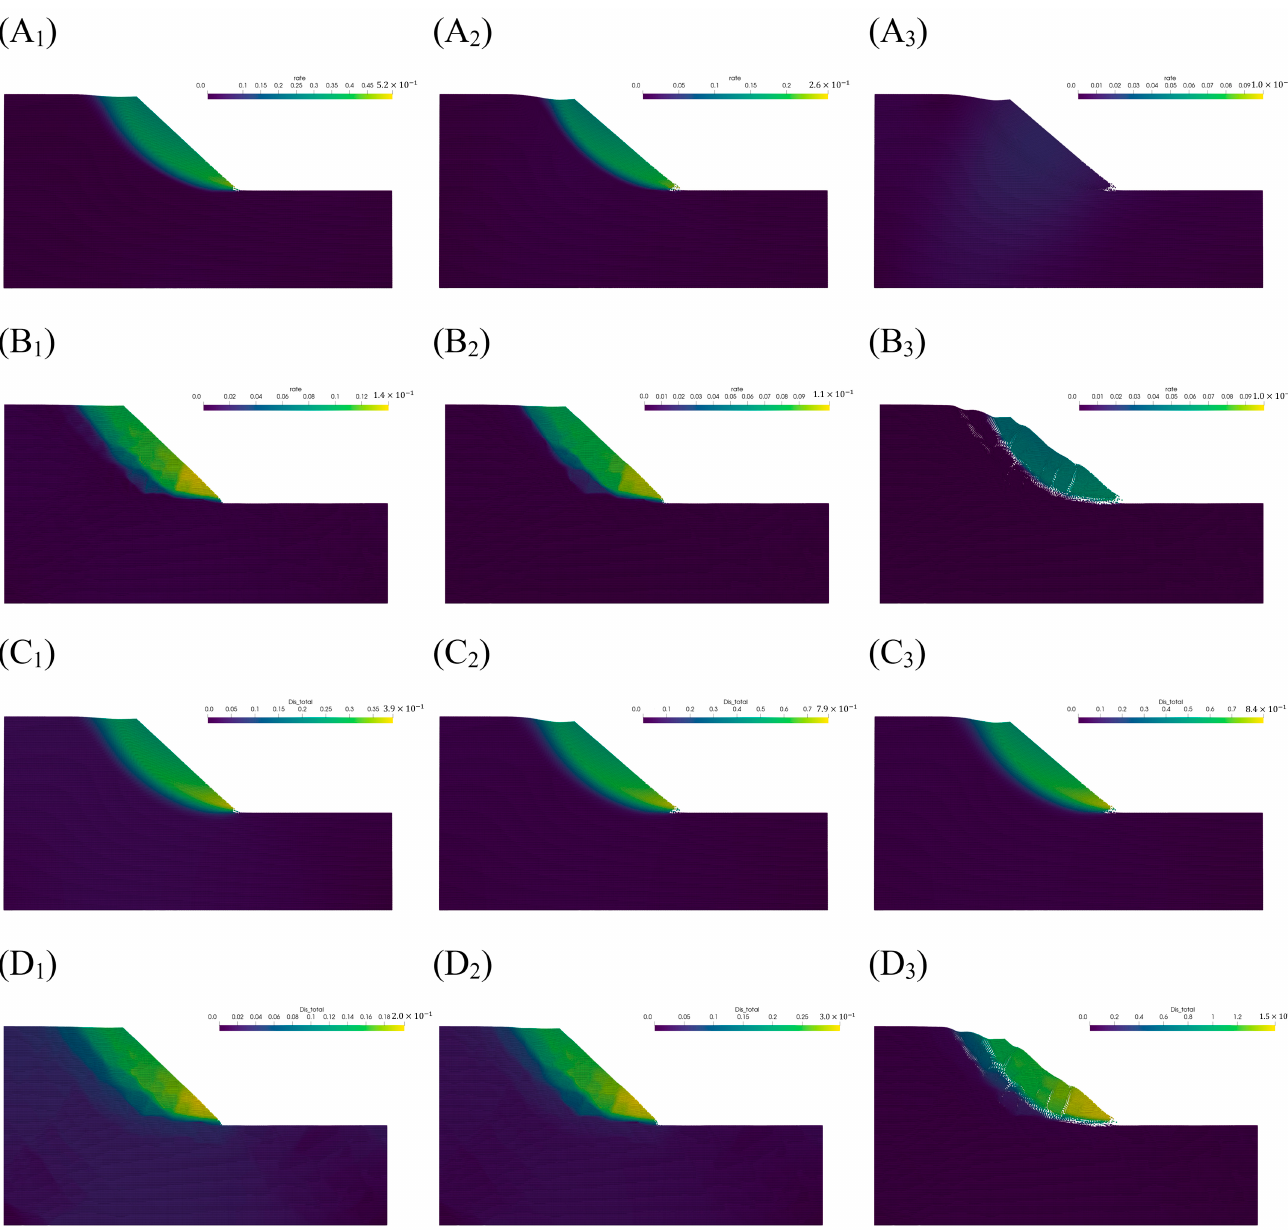
Figure 7. Rate and displacement cloud variation of pure soil slopes and SRM slopes for reduction factors equal to 1.5 and 1.9, respectively. ( A 1 – A 3 ) Rate distribution of pure soil slope at t = 3, 4, and 22 s. ( B 1 – B 3 ) Rate distribution of SRM slope at t = 3, 4, and 22 s. ( C 1 – C 3 ) Displacement distribution of pure soil slope at t = 3, 4, and 22 s. ( D 1 – D 3 ) Displacement distribution of SRM slope at t = 3, 4, and 22